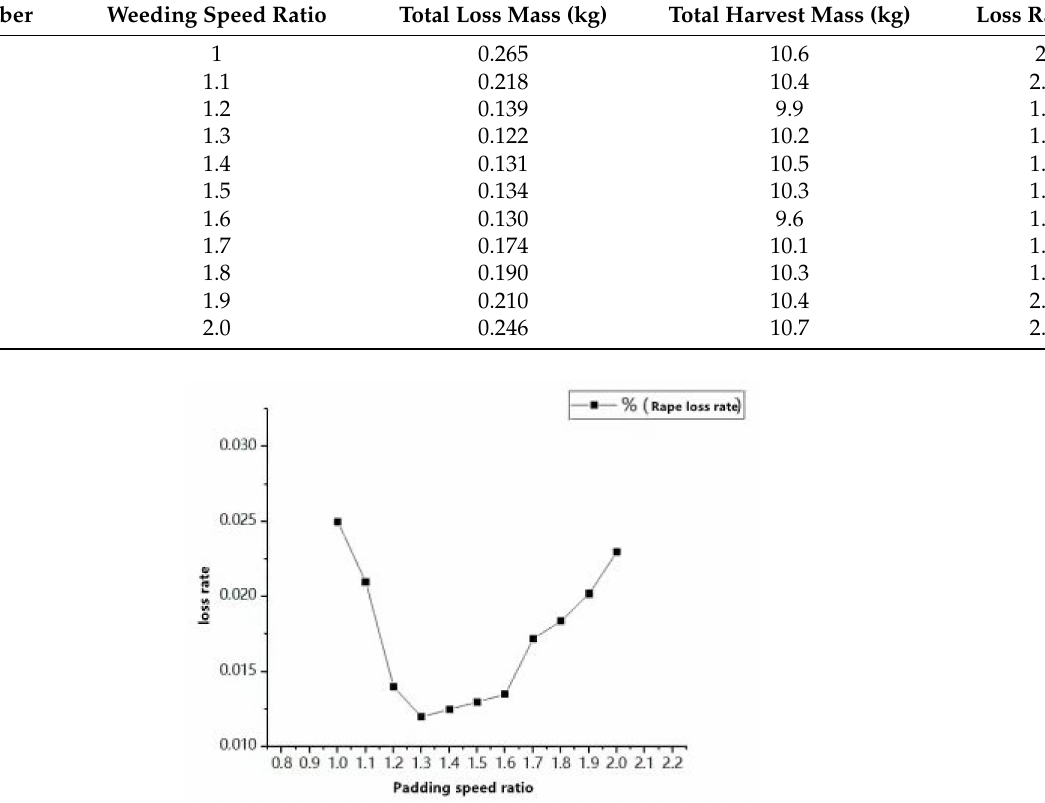
Figure 6. Rape-loss-rate line